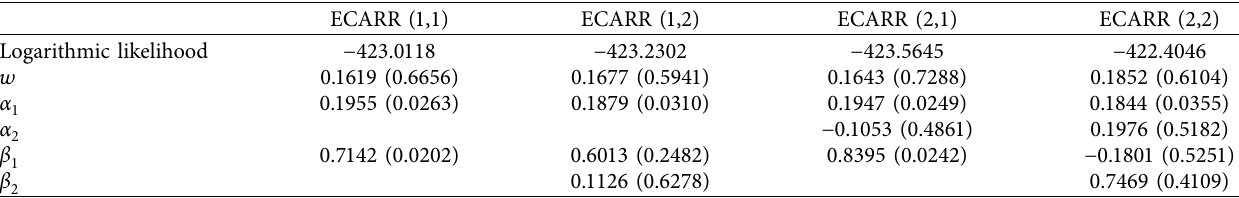
Figure 2: Financial losses of A-share listed companies in different sectors from 2015 to 2020. Table 1: Comparison of different lag order estimation results of the ECARR model based on B segment weekly data.